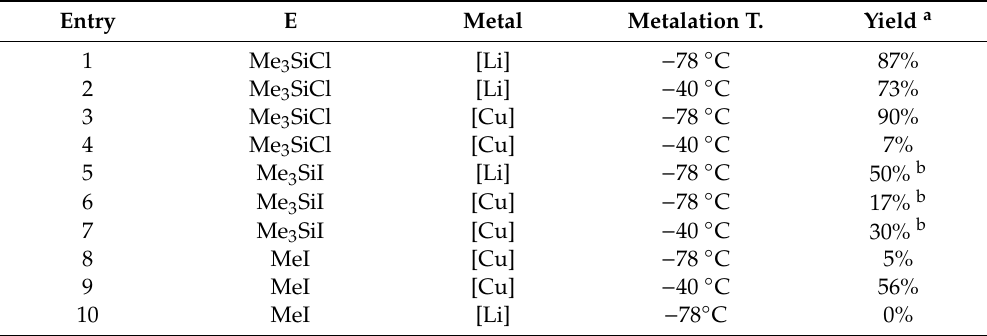
Table 4. To widen the scope of the transmetalation to softer electrophiles, an organocuprate was introduced by using CuCN · 2 LiCl as softer organometallic reagent. The transmetalation temperature varied from − 78 ◦ C to − 40 ◦ C.